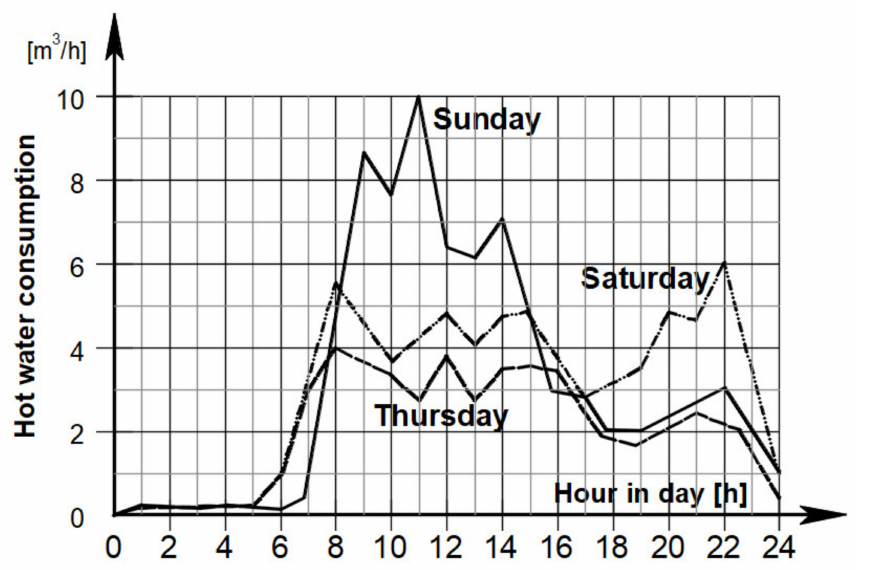
Figure 1. An example of hot water consumption for exemplary residential estate [56]. Due to the high variability of hot water consumption during the day, as well as week, month or year, the method described in the standard PN-B/92-01706 can be used. It allows consumption per capita and the number of inhabitants. The average daily consumption of